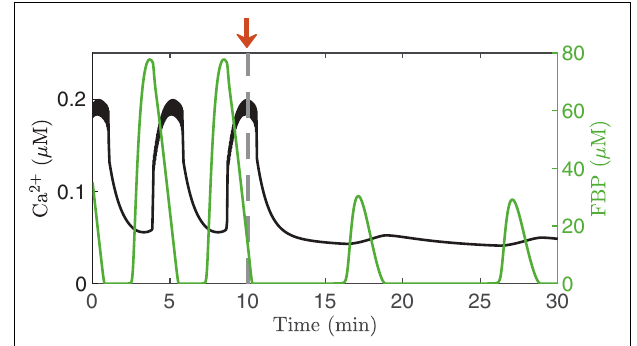
FIGURE 6 | Ca 2 + oscillations generated by the IOM, with FBP pulses superimposed. The glucose concentration is lowed from 11 to 5 mM at time t = 10 min. The electrical activity stops at the subthreshold glucose concentration, but intrinsic oscillations persist, resulting in small-amplitude Ca 2 + fluctuation. For this simulation, v PDH = 2 µ M / ms and g K ( Ca ) = 150